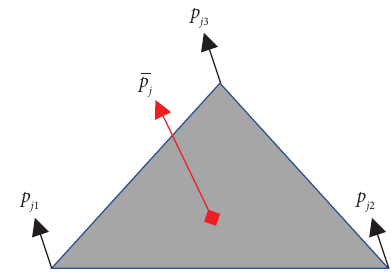
Figure 3: Te acoustic pressure on the element